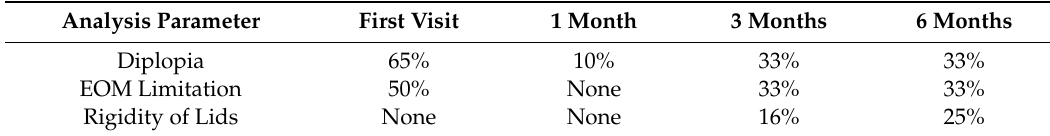
Table 5. The frequency of diplopia, lid rigidity and extraocular movements (EOM) restriction for patients treated with a titanium mesh covered with cartilage from the ear (12 patients).